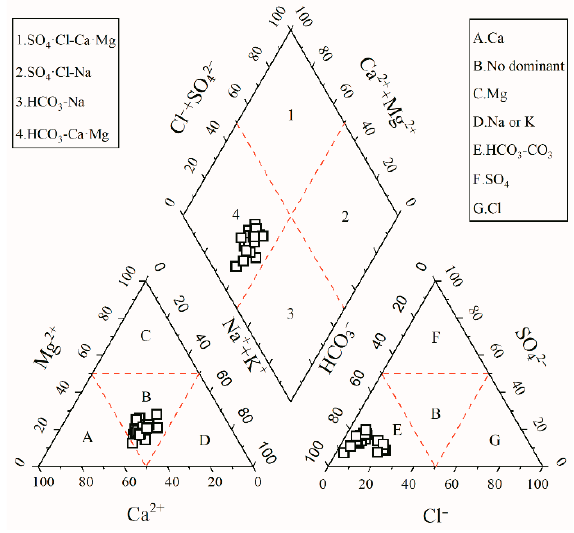
Figure 2. Piper trilinear diagram of Sr-rich groundwater.